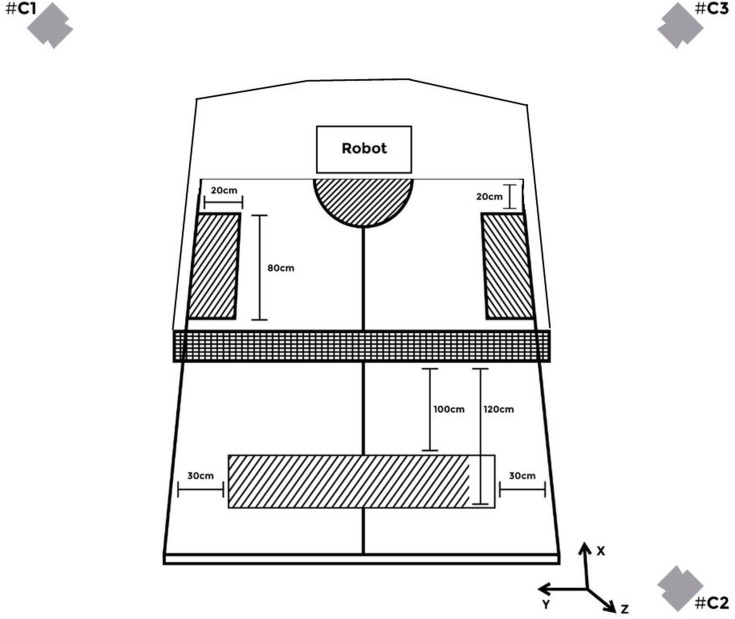
Schematic of the top view of the experimental setup. Shaded areas closer to the robot correspond to the three targets that the players could to reach, and the shaded area the other side of the net corresponds to the target zone the balls was thrown by the robot. #C1 = camera 1, #C2 = camera 2, #C3 = camera 3.